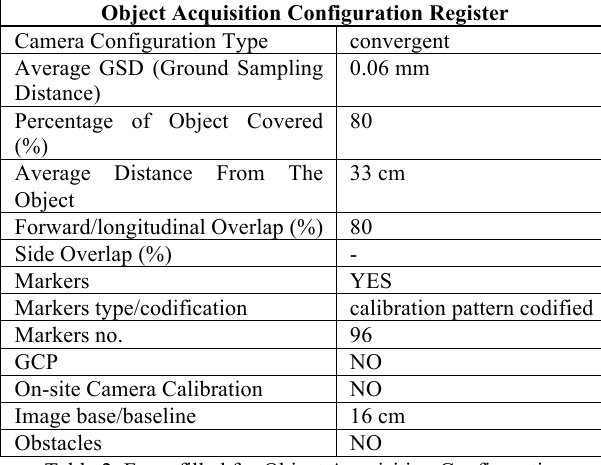
Table 2. Form filled for Object Acquisition Configuration